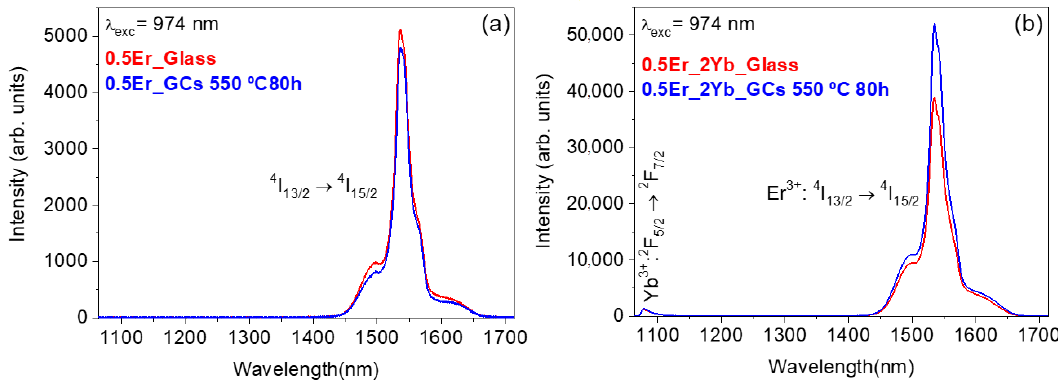
Figure 5. Near-infrared spectra (NIR) in the 1000–1750 nm range obtained under excitation at 980 nm of ( a ) Er 3+ -doped and ( b ) Er 3+ –Yb 3+ -codoped 70Si7Gd glass and GCs treated at 550 °C for 80 h.